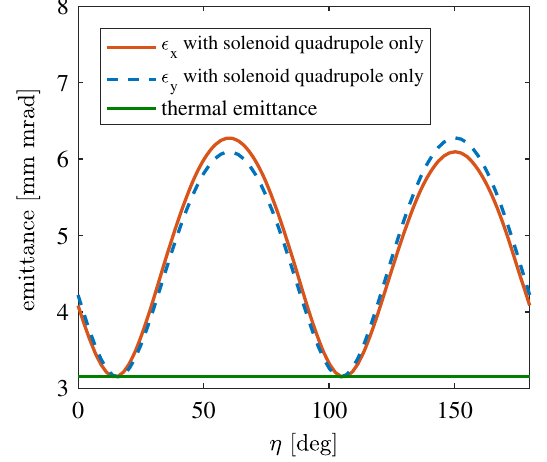
FIG. 3. Emittance at Position 2 based on the realistic rf gun (includes quadrupole) and ideal solenoid (no quadrupole com- ponent) at different laser injection phases. The gun launch phase corresponding to φ 0 ¼ 0 ° is 49°.